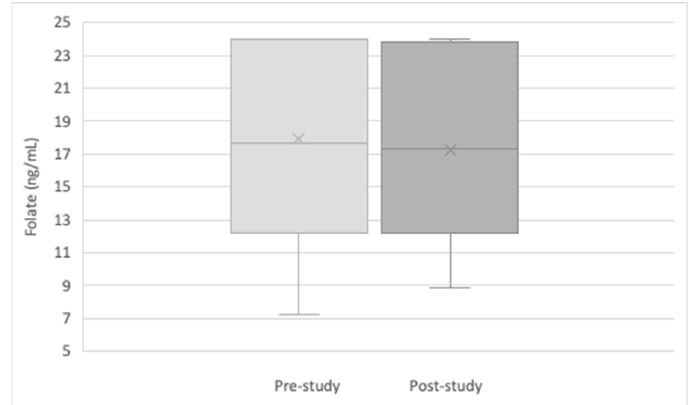
Figure 2. Pre- to post-study difference in folate (ng/mL).